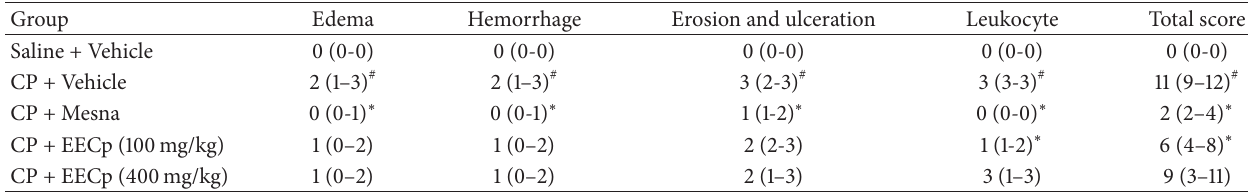
Table 2: Effect of ethanol extract of Caesalpinia pyramidalis (EECp) on the histopathological parameters during cyclophosphamide (CP)- induced cystitis in rats. Group Edema Hemorrhage Erosion and ulceration Leukocyte Total score Saline + Vehicle 0 (0-0) CP + Vehicle 2 (1–3)